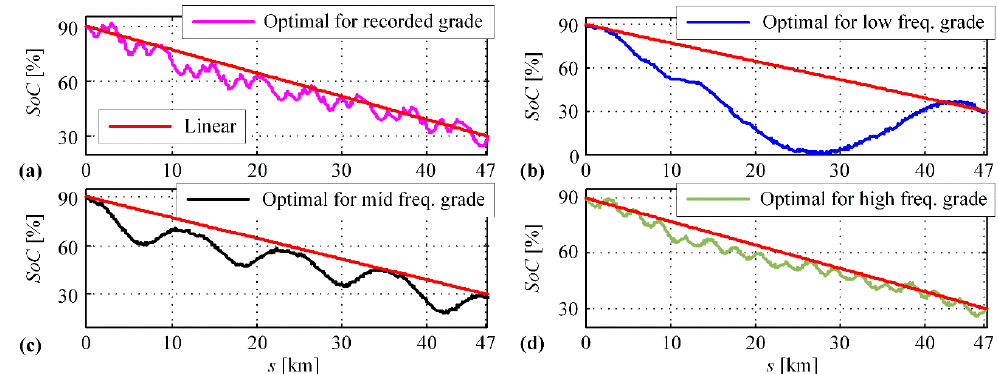
Figure 10. ( a ) Optimal SoC trajectories and corresponding shortest-length (linear) trajectories for 4xDUB driving cycle and recorded road grade from Figure 4b, ( b ) low frequency, ( c ) mid frequency and ( d ) high frequency sinusoidal road grade profiles from Figure 6a.